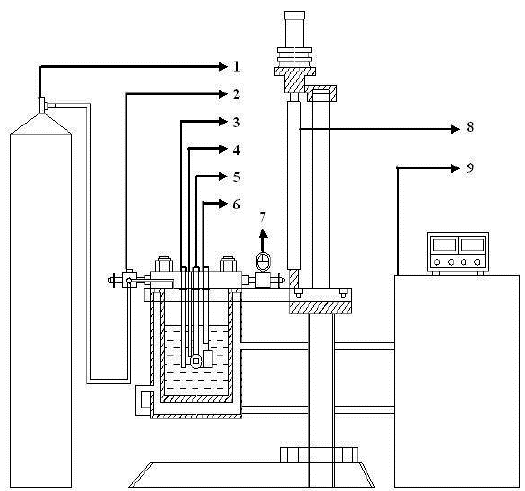
Figure 9. Schematic diagram of the deep ocean simulation device: (1) nitrogen cylinder; (2) valve; (3) solid reference electrode; (4) thermocouple; (5) working electrode; (6) counter electrode; (7) pressure meter; (8) automatic elevator and (9) temperature controller.